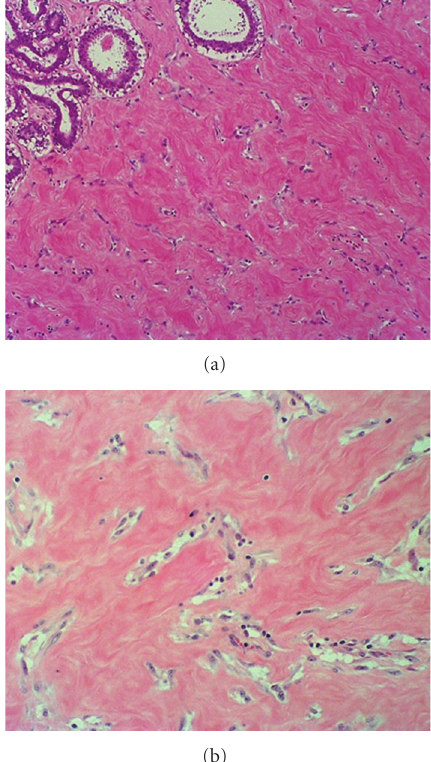
Figure 3: (a) Anastomosing groups of spindle cells in the stroma. Normal breast epithelium top left. (b) Stromal spindle cells which appear to be lining slit-like spaces devoid of red blood